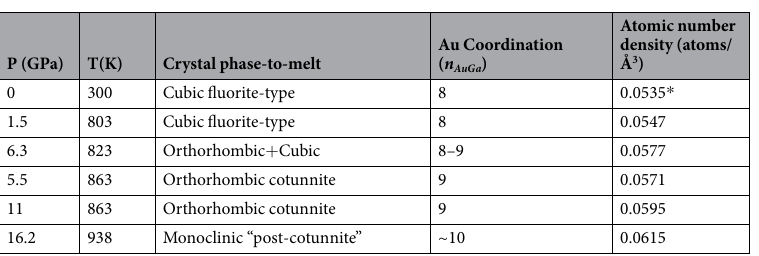
Table 2. Pressures, temperatures and initial atomic number densities used for EPSR simulations. * Amorphous (glass) state at ambient conditions: data from literature 7